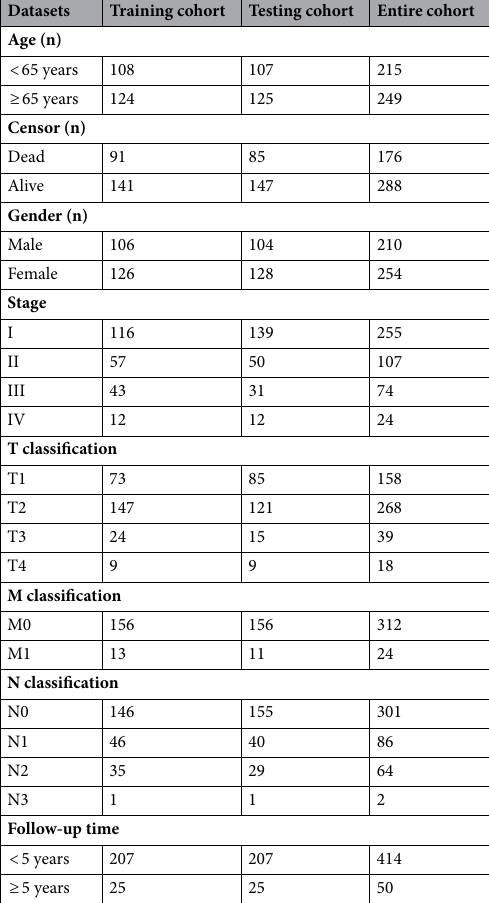
Table 1. Clinical variables of LUAD patients from